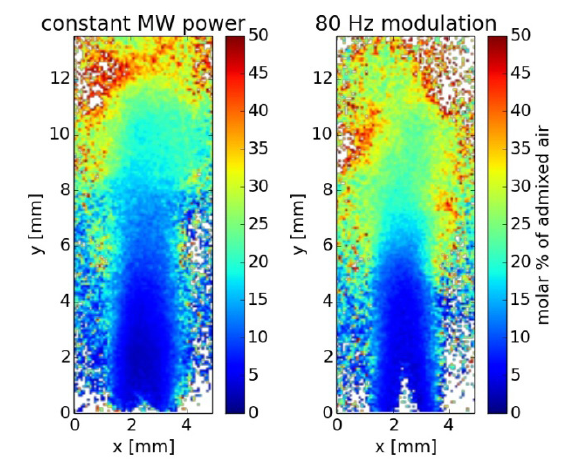
Figure 3 : Maps of the gas mixing for the case of constant MW input power (on the left) and MW input power modulated by 80 Hz (on the